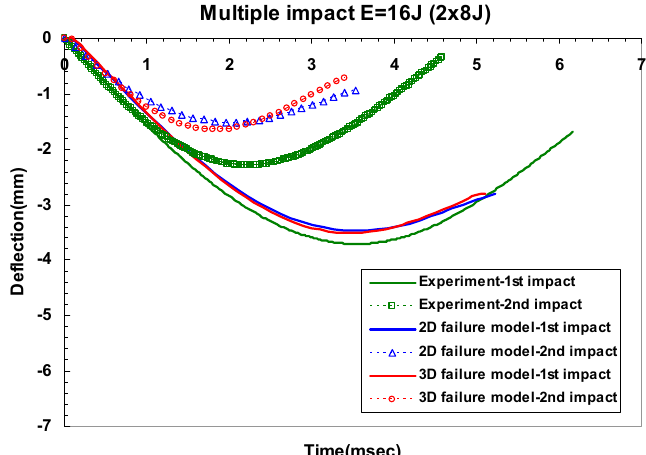
Figure 18. Difference between the predicted and measured central deflection for GLARE 5-2/1 under impact energy of 8 J.